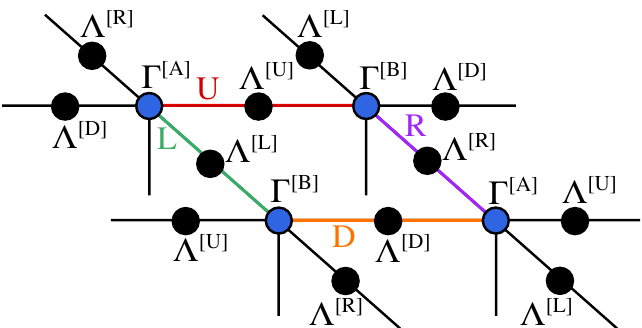
Figure 7: The iPEPS time evolution using Eq. (5) involves propagating four different bonds ‘U’, ‘D’, ‘R’, and ‘L’, indicated by different colours. The SU algorithm uses Vidal form with Γ [ A , B ] site tensors and Λ [ U , R , D , L ] diagonal bond matrices to represent iPEPS with a two-site unit